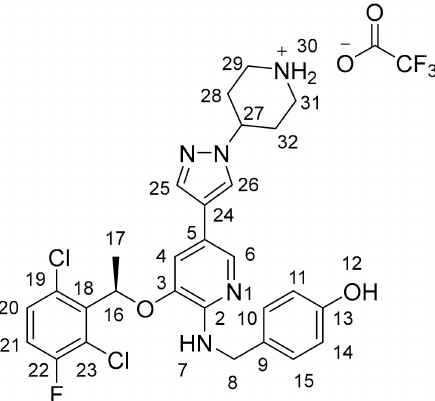
Figure 9. Structure and NMR numbering of compound C